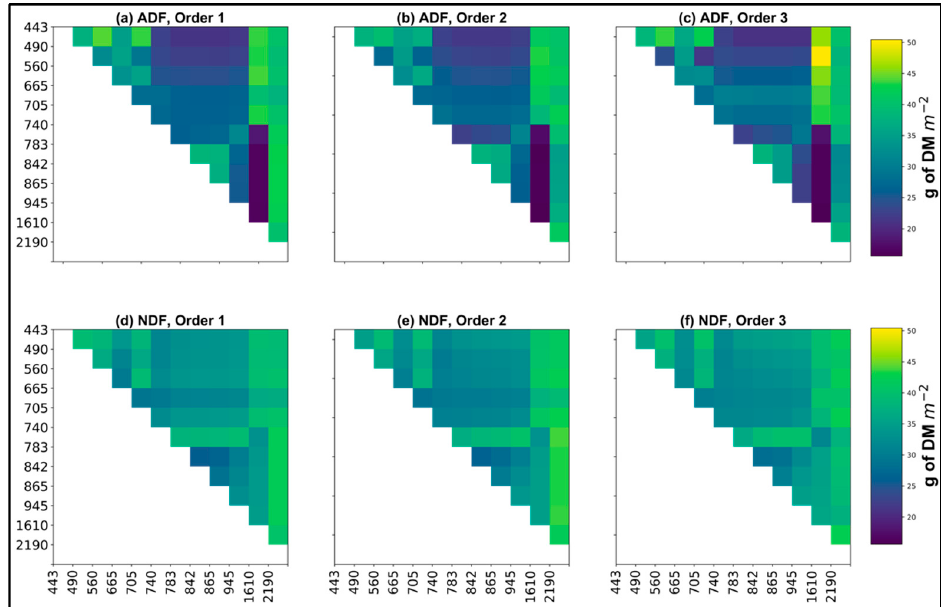
Figure 2. Two-dimensional matrix plot showing mean square errors ( MSE s) obtained for models built using all possible Sentinel-2-based two-band normalised difference indices (NDIs) for ( a – c ) acid detergent fibre (ADF, 39 samples) and ( d – f ) neutral detergent fibre (NDF, 39 samples). Table 4. Statistical indicators for the developed ‘best’ models for pasture quantity and quality parameters (39 samples for each parameter) using ‘leave one out’ cross validation. Only normalised models yielding mean square errors ( MSEs ) in the lowest 5th percentile (considering all possible models) are listed. The results in bold highlight models yielding highest Conr . Wave. Parameter Order (1)